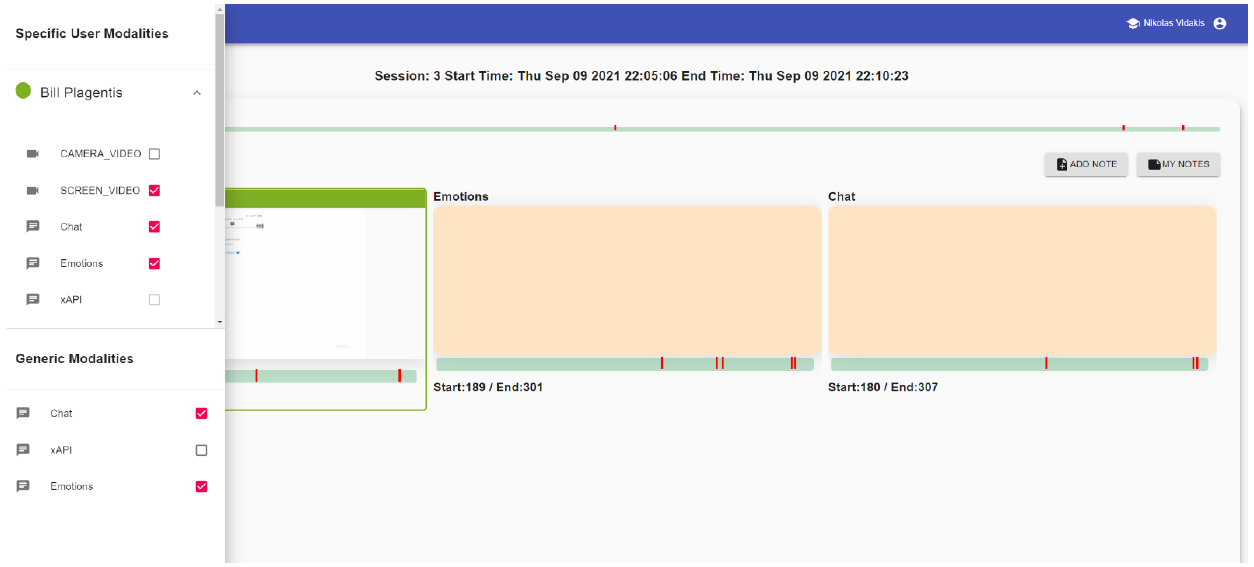
Figure 6. Open Studio